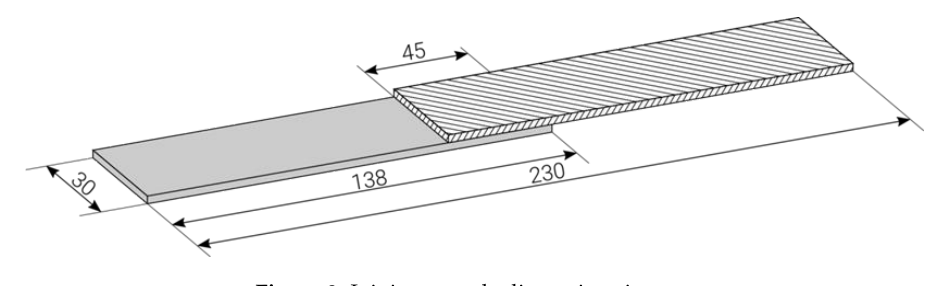
Figure 3. Joining sample dimensions in mm.